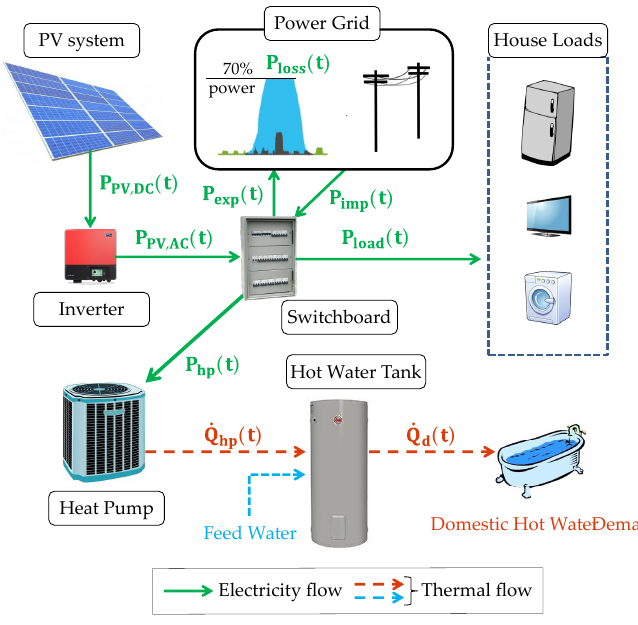
Figure 1. System under study and the considered power and heat